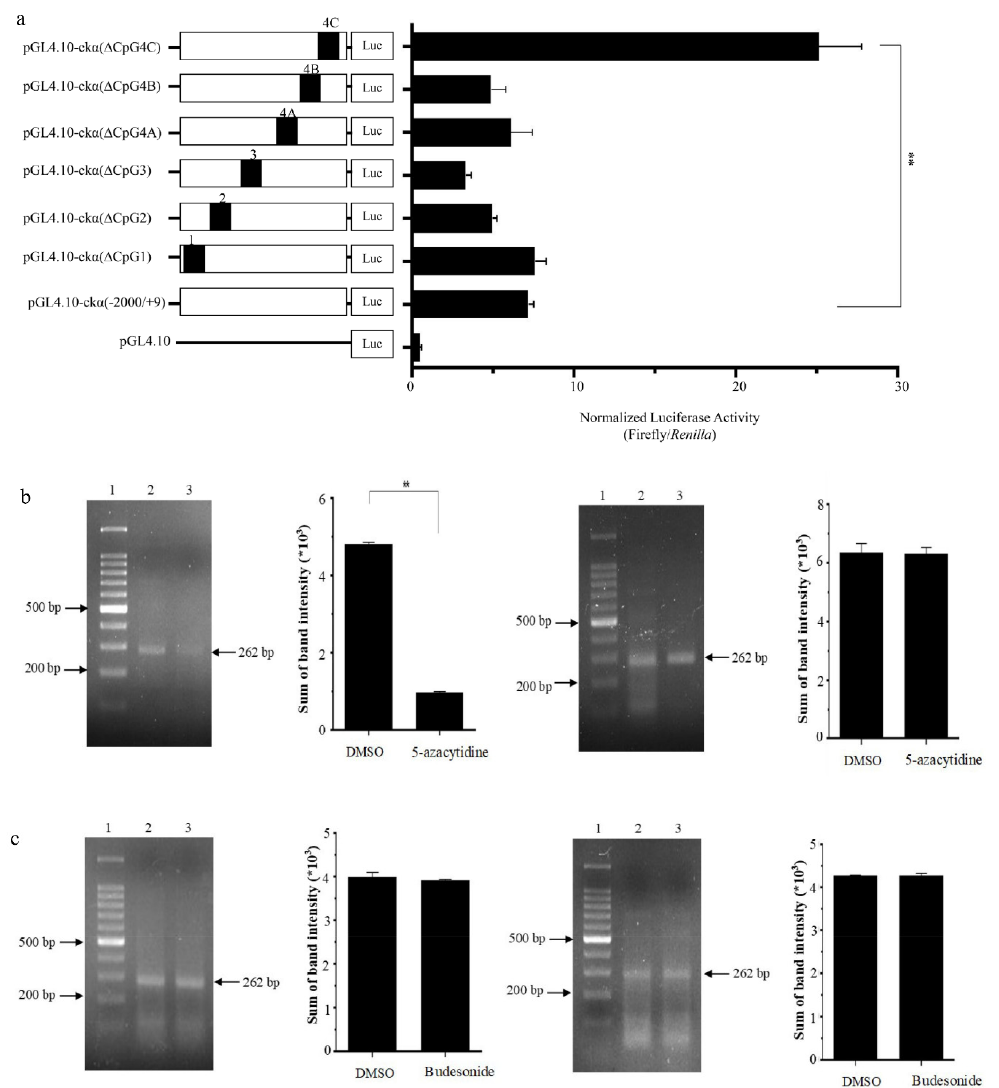
Figure 2. Deletion analysis of ck α CpG island and DNA methylation levels of CpG4C after epigenetic drug treatments. ( a ) Promoter activity of CpG island deletion constructs in MCF-7 cells. The closed rectangle on the left panel indicates the deletion of the CpG island. DNA methylation levels of CpG4C region after ( b ) 5-azacytidine and ( c ) budesonide treatments of MCF-7 (left panels) and MCF-10A (right panels) cells. Each bar represents the mean ± SEM of triplicate samples for three independent experiments. Statistical analysis was performed using Student’s t -test (** p < 0.01). Lane 1: size marker; 2: negative control; and 3: treated.